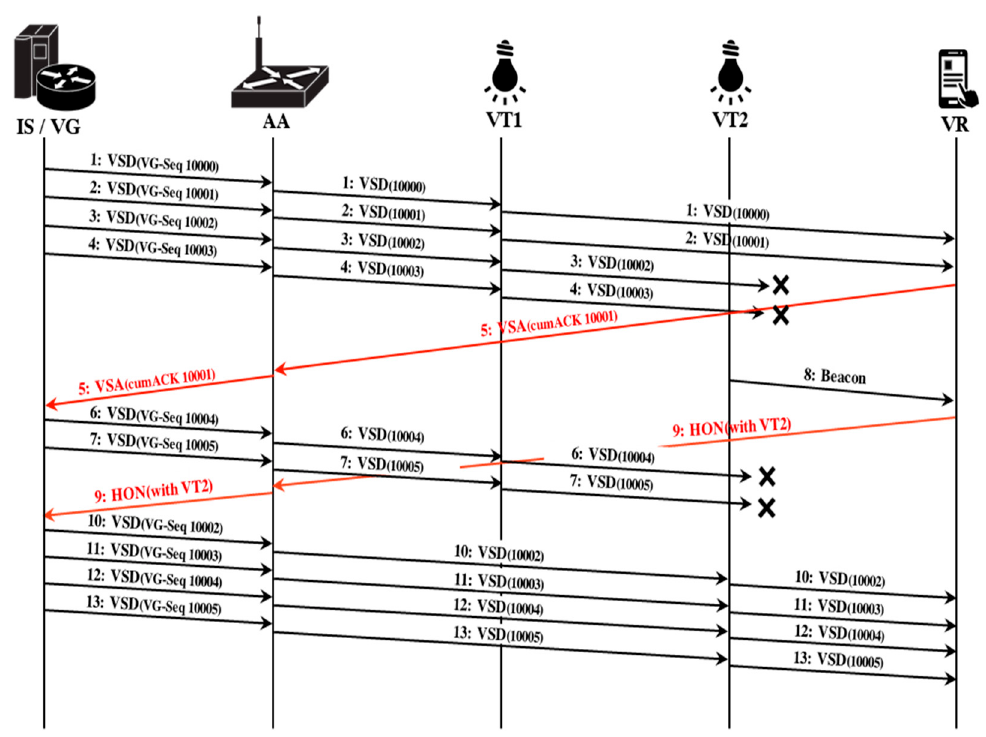
Figure 15. VT handover operations.